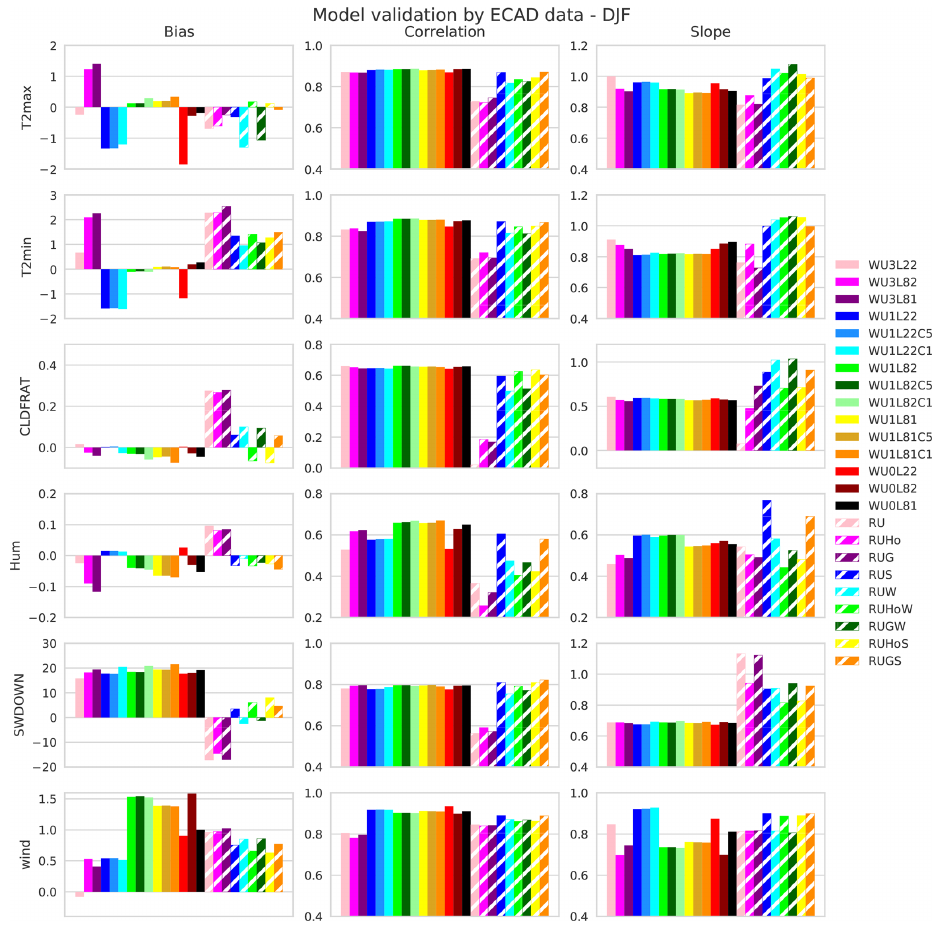
Figure 4. Statistical evaluation of individual simulations using ECAD station data for selected variables in the winter season. Units are ◦ C (temperature), fractions of 1 (cloud cover and relative humidity), Wm − 2 (downward shortwave radiation) and ms − 1 (wind